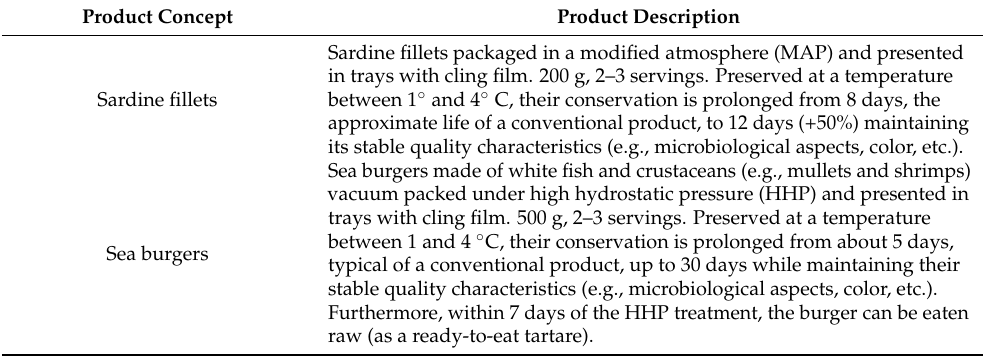
Table 1. Product concept